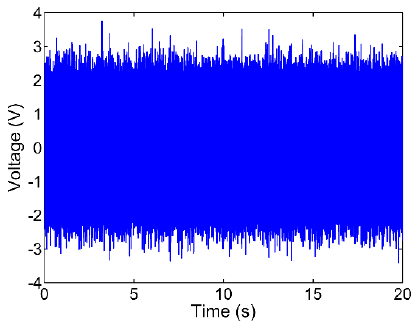
Figure 3. Response signal obtained from the vibration tests.